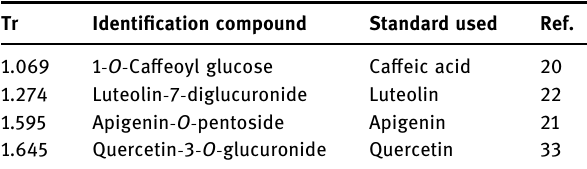
Table 1: Chemical pro fi le of polyphenol - rich fraction from the leaves of Withania adpressa Coss. ex